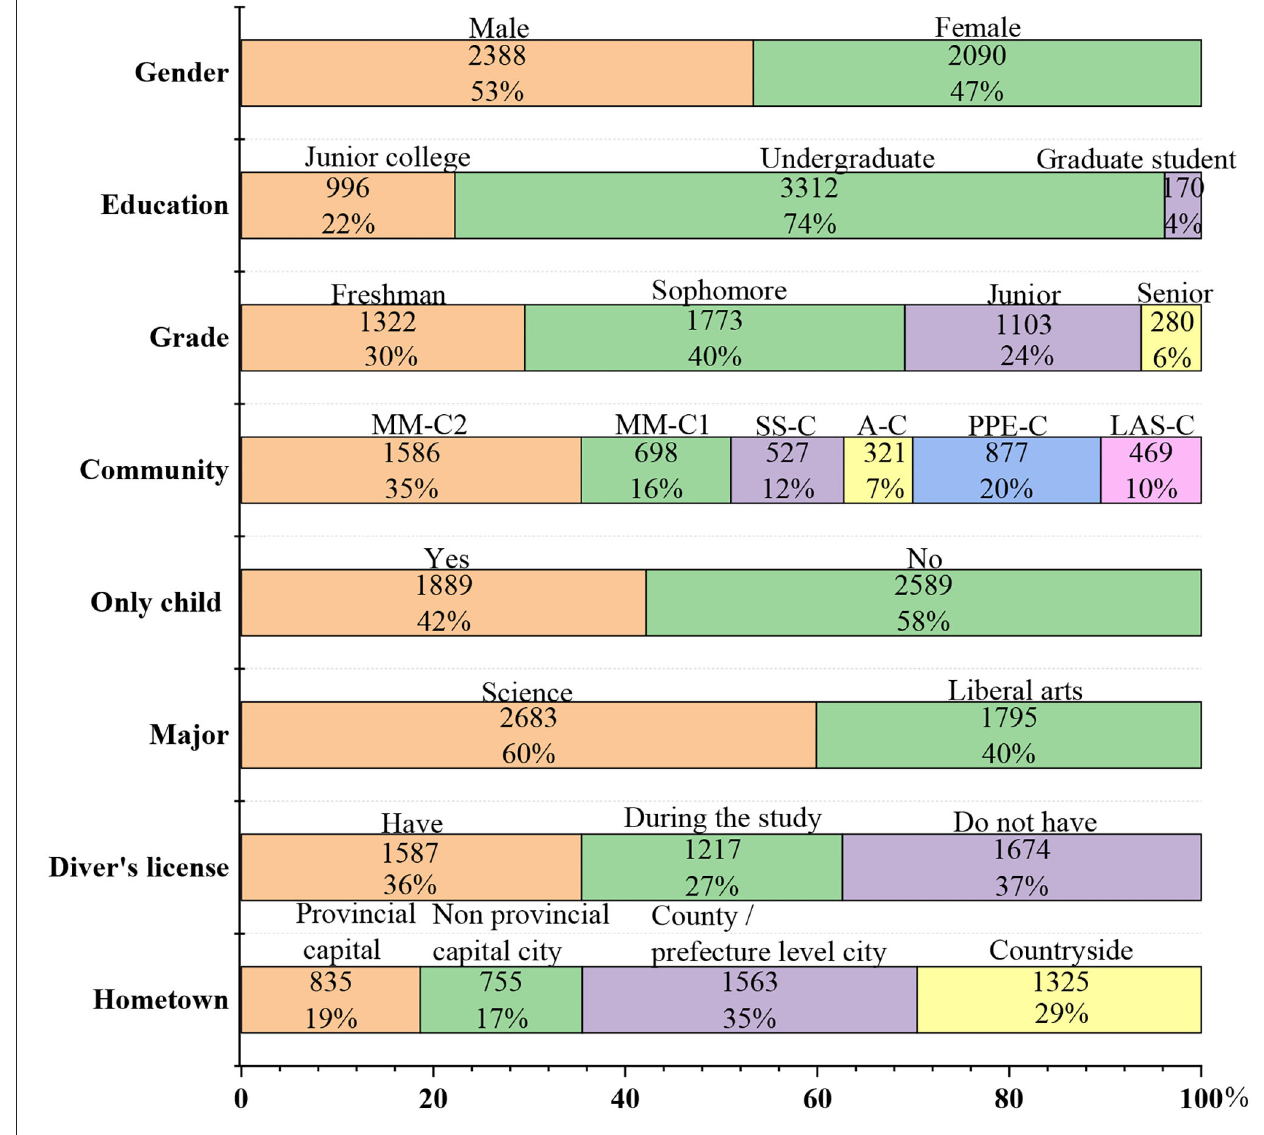
FIGURE 1 | Basic information of